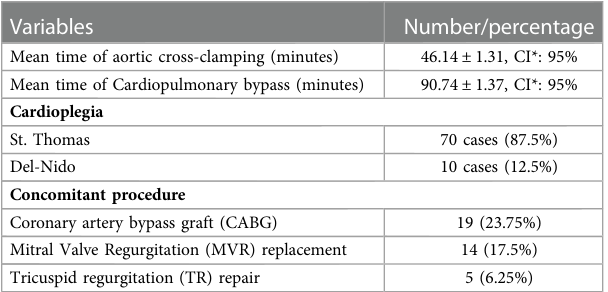
TABLE 2 Intraoperative data.